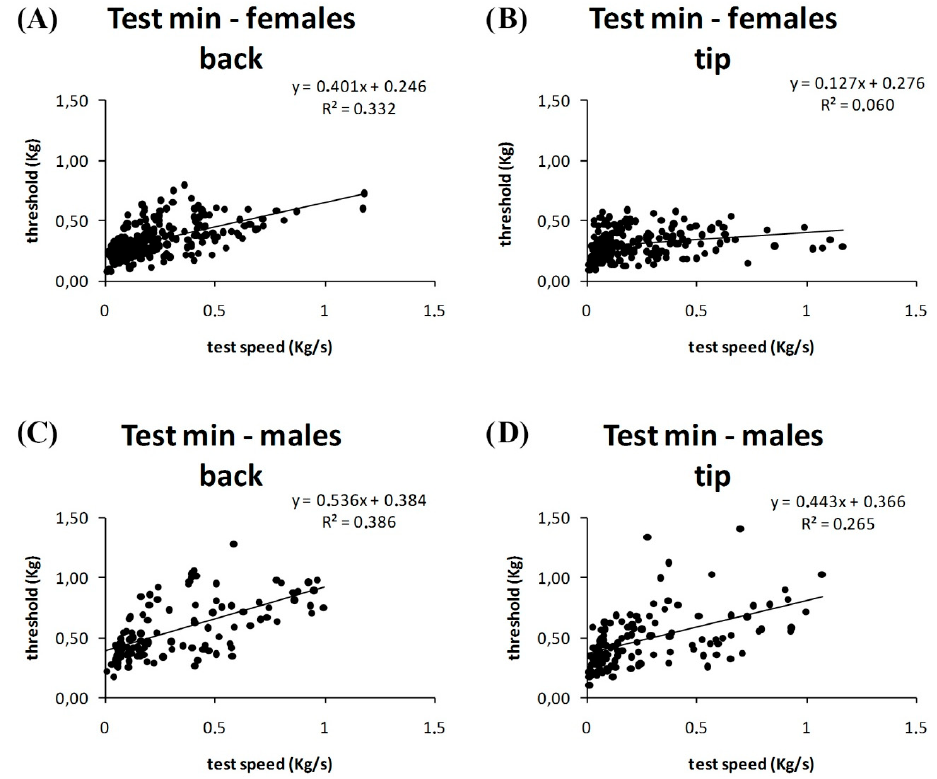
Figure 6. Differences in autoalgometric threshold divided by site of stimulation: ( A , B ) female; ( C , D ) male.